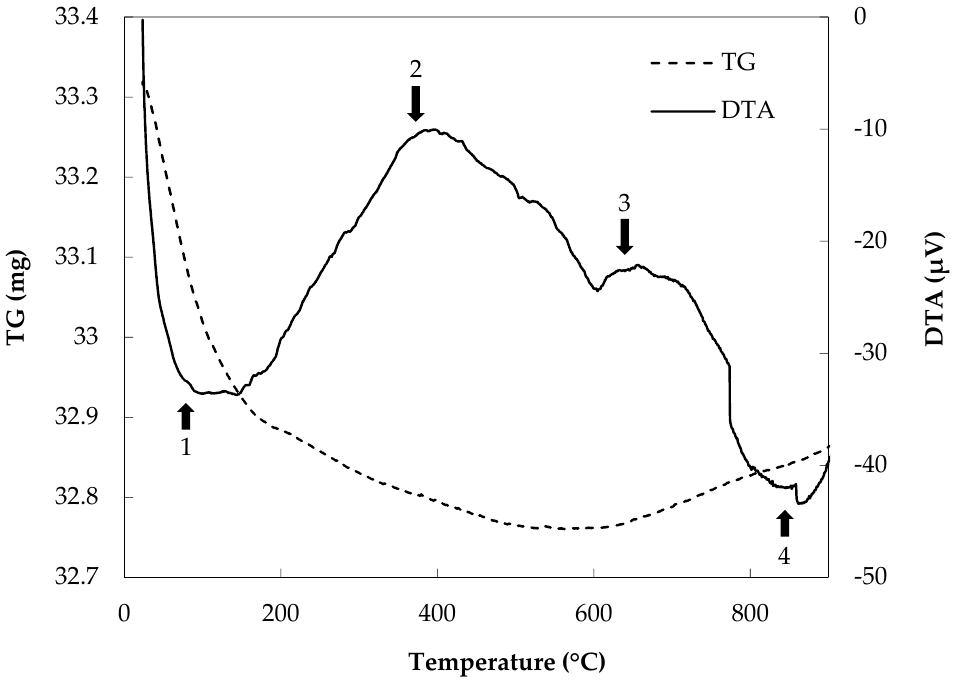
Figure 8. Thermogravimetric and differential analysis (TG-DTA) patterns for JB-1a: 1. dehydration, 2. oxidation decomposition, 3. oxidation, and 4. melting.